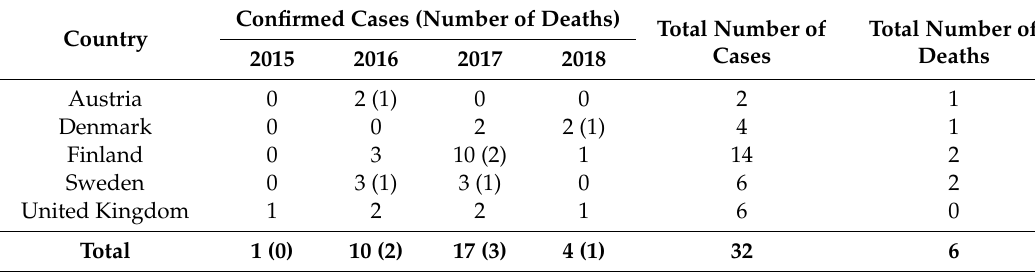
Table 3. Cases of Listeriosis verified in five countries in Europe between 2015 and